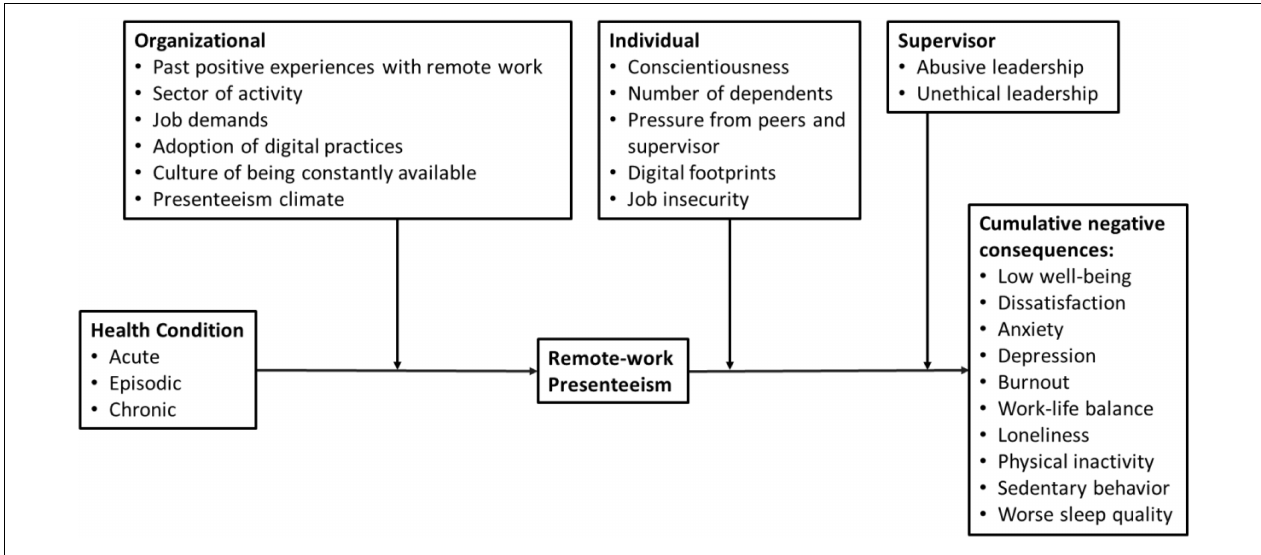
FIGURE 2 | Remote-working presenteeism behavior